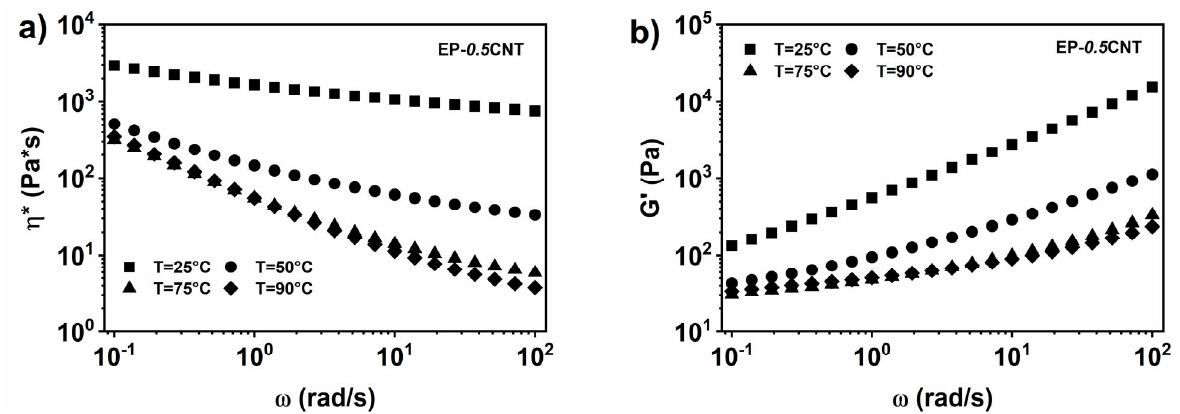
Figure 5. ( a ) Complex viscosity ( η *) vs. frequency ( ω ) for EP ‐ 0.5 CNT, at different temperatures; ( b ) ( b ) storage modulus (G’) vs. frequency ( ω ) for EP- 0.5 CNT, at different temperatures. storage modulus (G’) vs. frequency ( ω ) for EP ‐ 0.5 CNT, at different temperatures. 3.1.4. EP Epoxy Mixture Loaded with 1% wt. of the Healing Molecule and 0.5% wt. of CNT